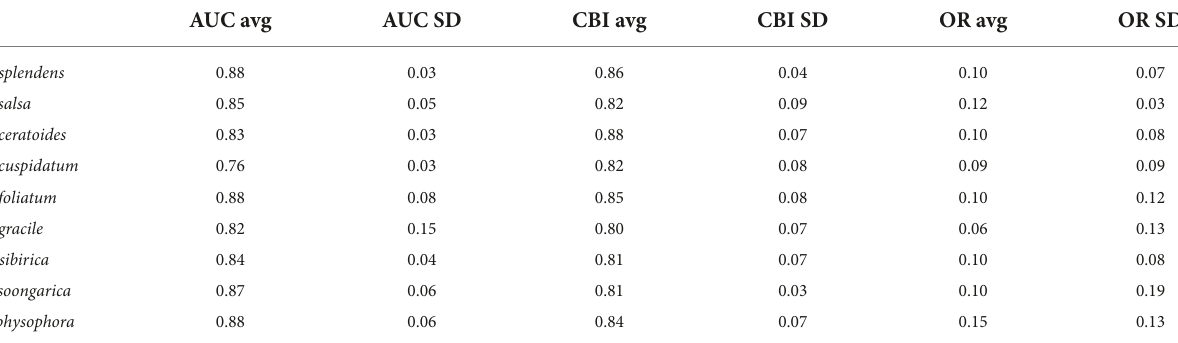
TABLE 1 The average and standard deviation of AUC, CBI, and the omission rate (OR). AUC avg AUC SD CBI avg CBI SD OR avg OR